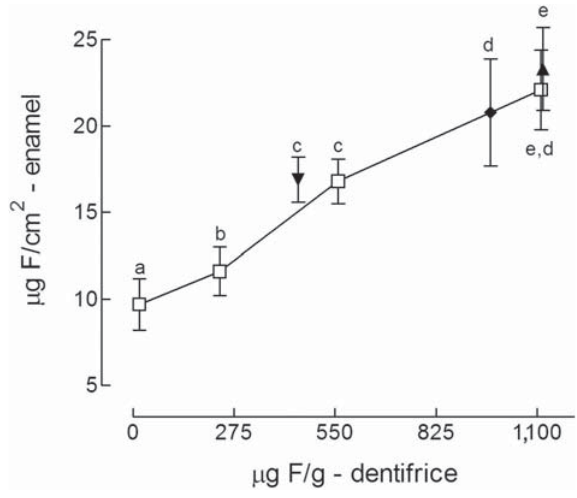
Figure 3 - Fluoride concentration (mean±standard (cid:4)(cid:8)$(cid:2)(cid:6)(cid:7)(cid:2)(cid:19)(cid:3)(cid:12)(cid:9) (cid:3)%(cid:29)(cid:23)&(cid:9) (cid:2)(cid:3)(cid:9) (cid:8)(cid:3)(cid:6)!(cid:8)=(cid:9) (cid:6)(cid:5)(cid:5)(cid:19)(cid:20)(cid:4)(cid:2)(cid:3)(cid:25)(cid:9) (cid:7)(cid:19)(cid:9) (cid:4)(cid:8)(cid:3)(cid:7)(cid:2)(cid:18)(cid:20)(cid:2)(cid:5)(cid:8)’(cid:9) (cid:13) (cid:3) ” indicate dentifrice placebo, 275, 550 and 1,100 μg F/g; (cid:13)(cid:16)(cid:15)(cid:9)(cid:2)(cid:3)(cid:4)(cid:2)(cid:5)(cid:6)(cid:7)(cid:8)(cid:9)Q(cid:20)(cid:8)#(cid:7)(cid:12)(cid:9)(cid:13)(cid:17)(cid:15)(cid:9)(cid:2)(cid:3)(cid:4)(cid:2)(cid:5)(cid:6)(cid:7)(cid:8)(cid:9)(cid:21)(cid:22)(cid:23)(cid:9)(cid:24)(cid:25)(cid:9)(cid:26)(cid:27)(cid:25)(cid:12)(cid:9)(cid:13) (cid:2) ” indicate 1,000 μg F/g. Distinct letters represent statistically